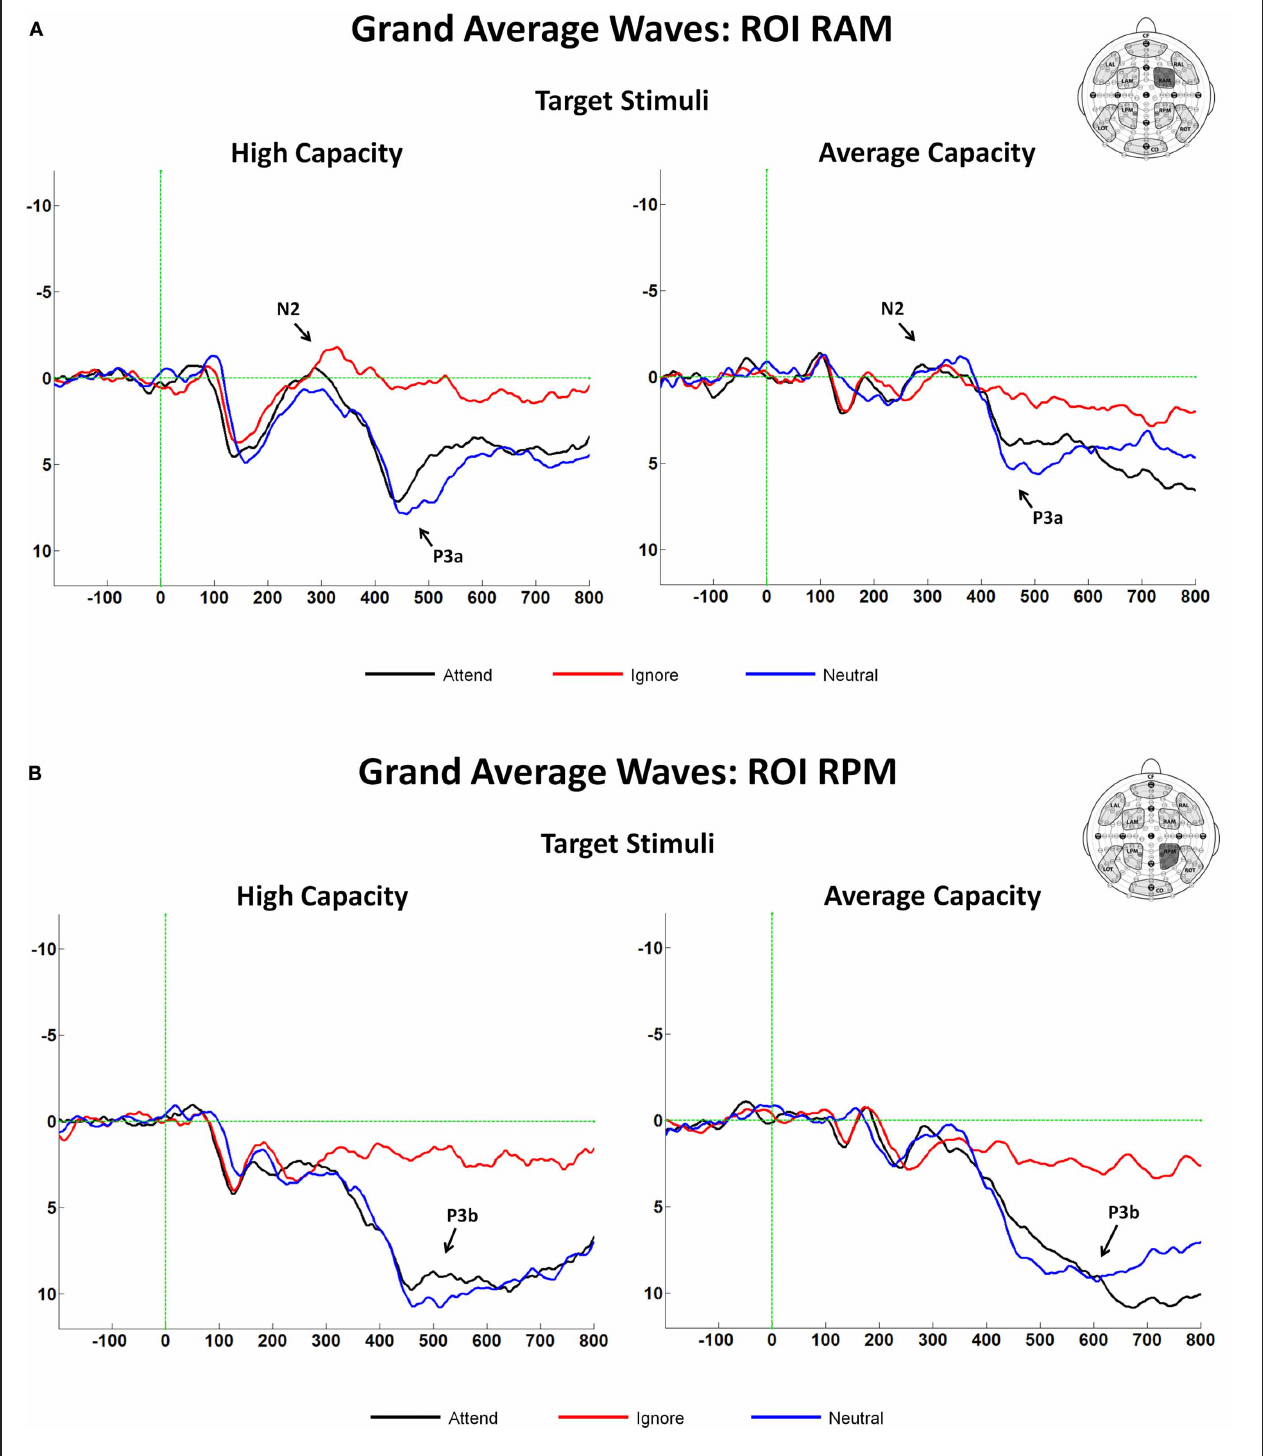
FIGURE 8 | (A) Grand average ERP responses at the fronto-central ROI, RAM in response to target stimuli for high capacity and average capacity subjects. Arrows illustrate the anterior N2 and P3a components; (B) Grand average